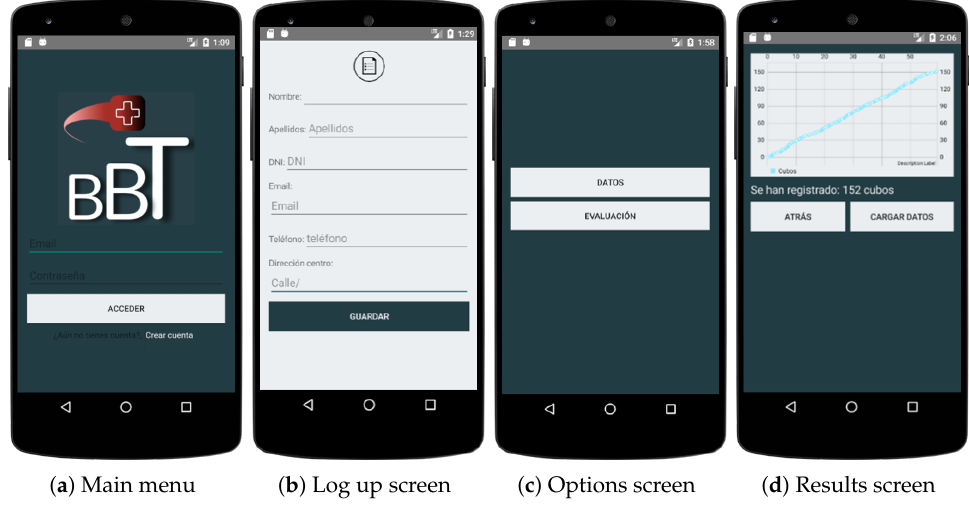
Figure 8. Screens of the mobile application for the automated